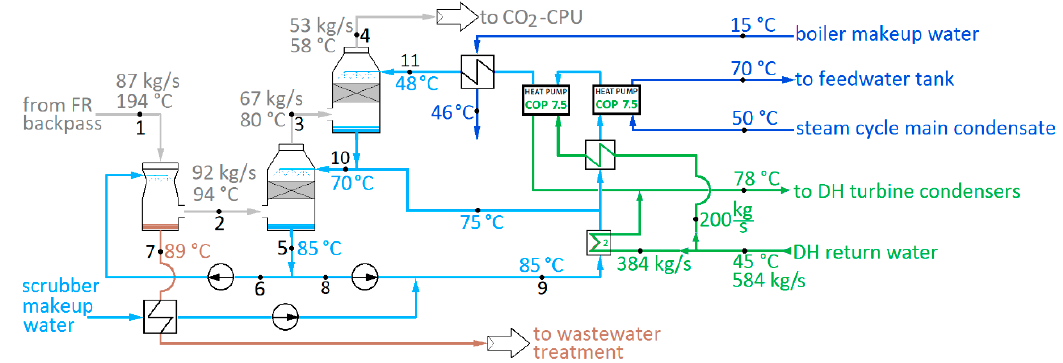
Figure 4. Heat recovery scheme with gas ( 1 ) entering a venturi scrubber (VS) at 194 °C. Cooled flue gas ( 2 ) at increased moisture enters the sequential packed bed scrubbers (HRS), exits the first one at ( 3 ), and from the final one to the stack at reduced moisture and temperature ( 4 ). Liquid water ( 5 ) from the HRS is used for VS spray ( 6 ) and heat consumers ( 8 ). Water from VS ( 7 ) is sent to waterwater treatment after heat recovery to makeup water which is mixed into the stream to heat consumers ( 9 ). Cooled water ( 10 and 11 ) is used as spray water for both of the HRS. Grey streams are gas, light blue scrubber circulating water, dark blue boiler water, green DH water, and brown wastewater.